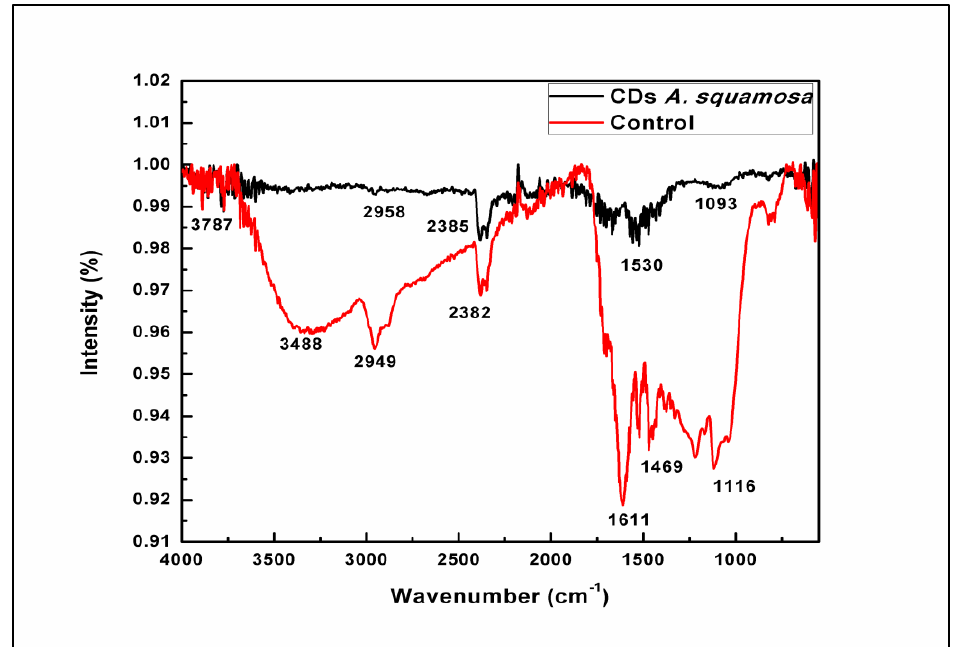
Figure 5. Fourier transform infrared (FTIR) spectral analysis of A. squamosa CDs.